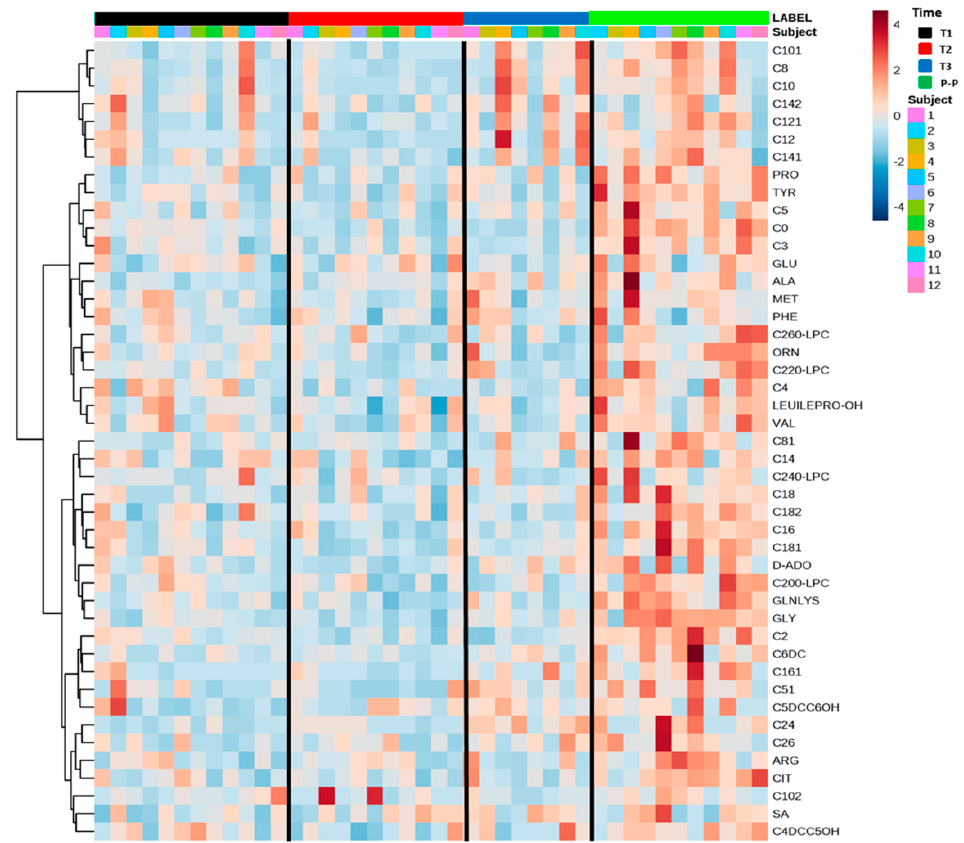
Figure 4. The heatmap displays data related to amino acids (AAs), free carnitine (C0), acylcarnitines (ACCs), succinyl acetone (SA), nucleosides, and lysophospholipids (LPCs) in the form of colored cells. It provides direct visualization of the relative levels of individual samples and time series. At the top of the image, the black bar indicates the first trimester of pregnancy (T1), the red bar indicates the second trimester of pregnancy (T2), the blue bar indicates the third trimester of pregnancy (T3), and the green bar indicates the post-partum period. The color code describes high serum levels (red) and low serum levels (blue) of each metabolite.